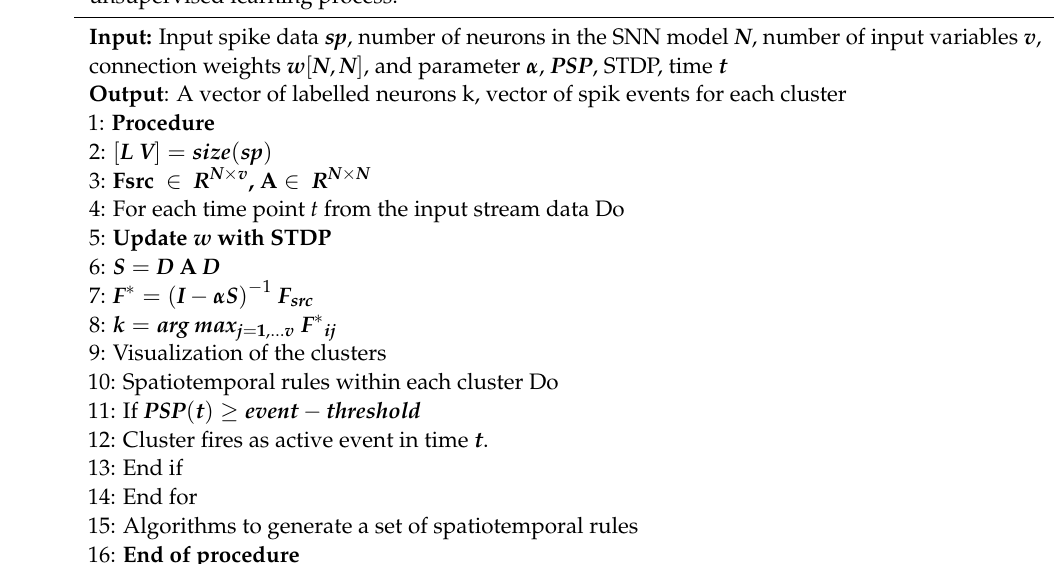
Algorithm 1. The dynamic spatiotemporal clustering algorithm at time point t of the unsupervised learning